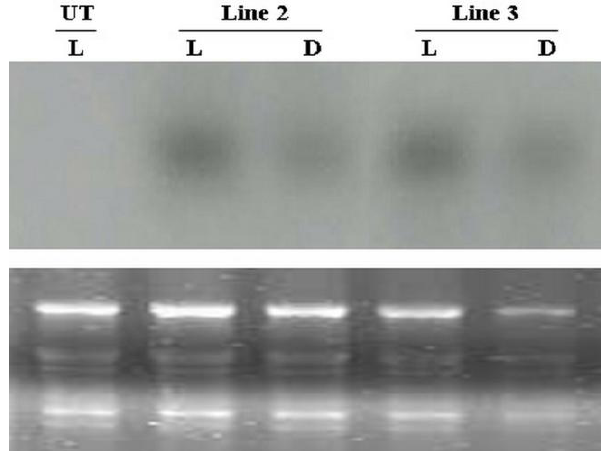
Figure 5. Light regulation of the AcRbcS promoter in transformed A. convolutus . Total RNA loaded on the gel was hybridized with a gusA -specific probe ( upper panel ). Total RNA was isolated from two transformed lines (lines 2 and 3) and an untransformed cell (UT) grown under continuous light for 3 days after 1-day subculture (L) and then transferred to dark for 24 h (D). Ethidium bromide staining of ribosomal RNA samples used to demonstrate equivalent loading ( lower panel